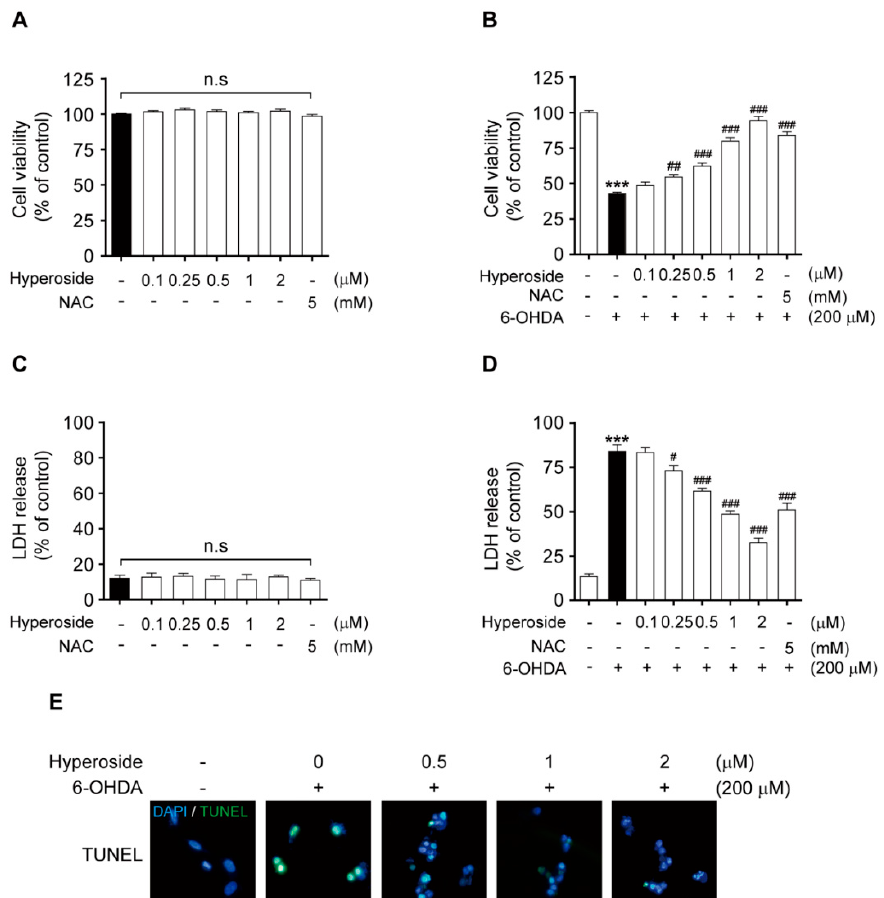
Figure 2. Effects of hyperoside on SH-SY5Y cells ( A and C ). Cells were pretreated with the indicated concentrations of hyperoside or N -acetylcysteine (NAC) for 24 h. Hyperoside protects against 6-hydroxydopamine (6-OHDA)-induced cell death ( B ) and lactate dehydrogenase (LDH) release ( D ) in SH-SY5Y cells. Cells were pretreated with the hyperoside (0.1–2 μ M) or NAC (5 mM) for 4 h and then exposed to 200 μ M 6-OHDA for 24 h. Error bars indicate the mean ± the standard error of the mean (SEM) ( n = 6). Hyperoside prevents 6-OHDA-induced DNA fragmentation ( E ). DNA fragmentation was assayed using terminal deoxynucleotidyl transferase dUTP nick end labeling (TUNEL) staining. Cells were pretreated with the hyperoside (0.5–2 μ M) for 4 h and then exposed to 200 μ M 6-OHDA for 24 h. Images shown are representative of three experiments and visualized by fluorescence microscopy (20×). *** p < 0.001 vs. the control group. # p < 0.05, ## p < 0.01 and ### p < 0.001 vs. the 6-OHDA-treated group. n.s.: not significant. Scale bar: 200 μ m.